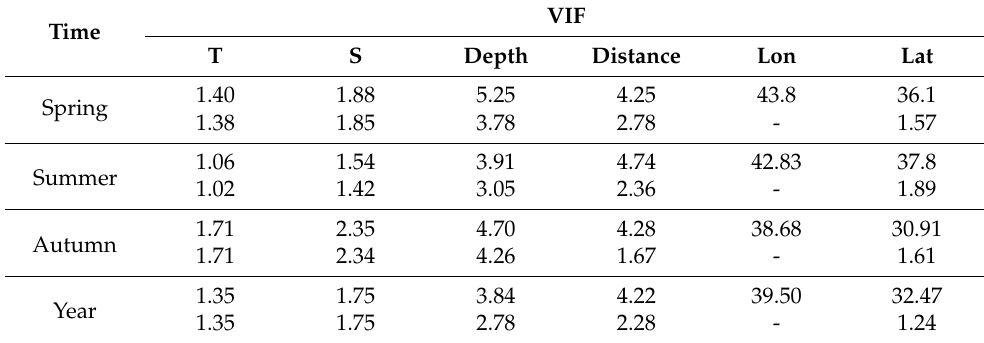
Table 1. Collinearity test of explanatory variables in different seasons.